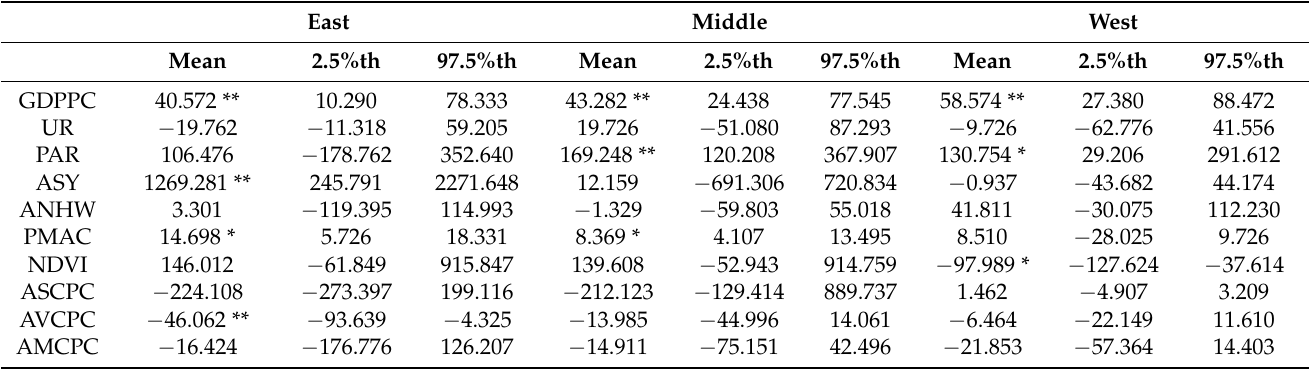
Table 4. The B-LASSO model’s estimated regression coefficients of the 10 influence factors on THEPC (Chinese yuan) at subnational scale, east, middle, and west of the Chinese mainland.